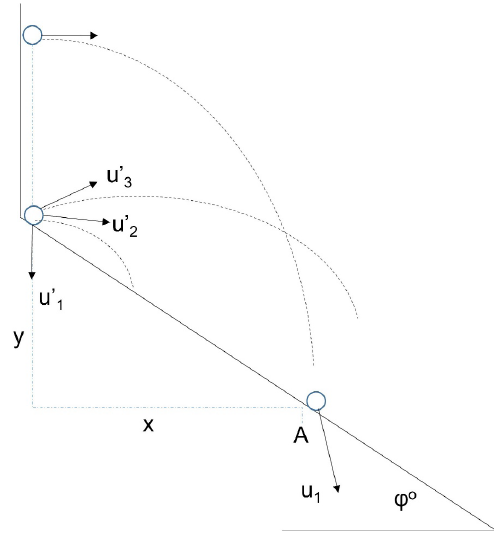
Figure 7. Theoretical scheme of rock block motion with an initial velocity and with zero initial velocity.